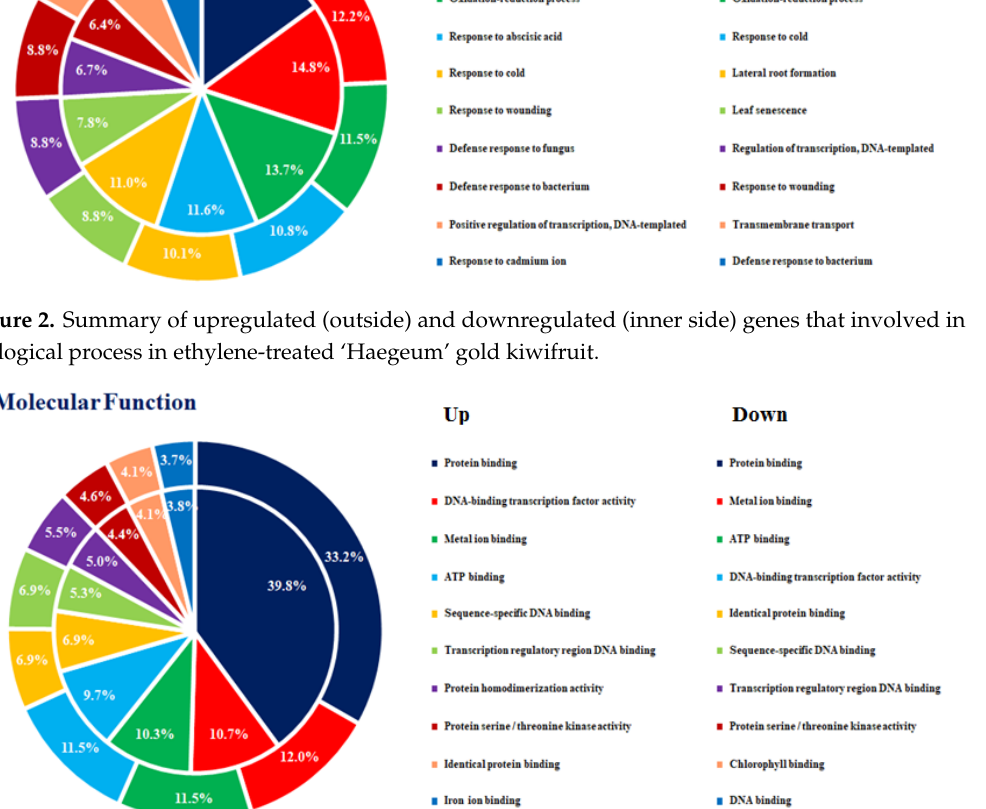
Figure 3. Summary of upregulated (outside) and downregulated (inner side) genes that involved in